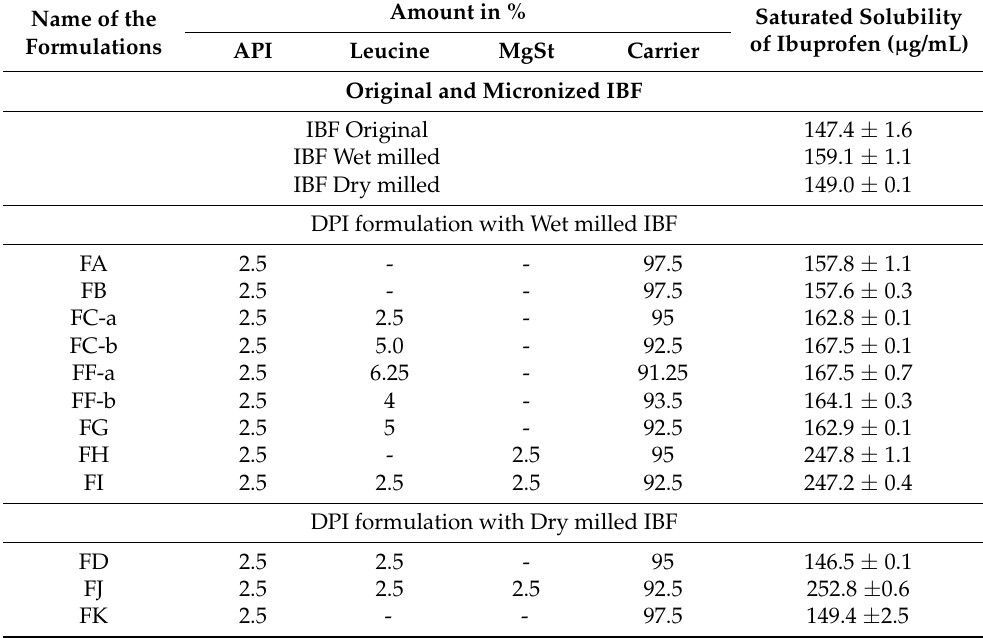
Table 5. Saturated solubility of original, micronized IBF with DPI formulation mixtures in PBS at 22–25 ◦ C (Mean ± SD, n =